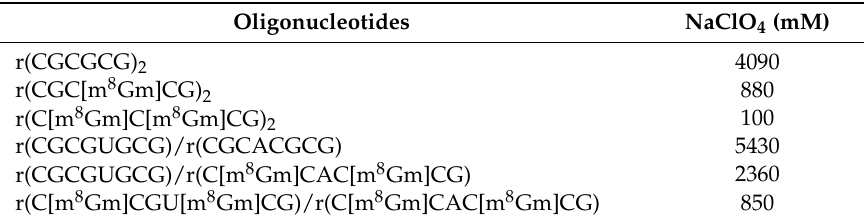
Table 1. Midpoint NaClO 4 concentration in A-Z transition.